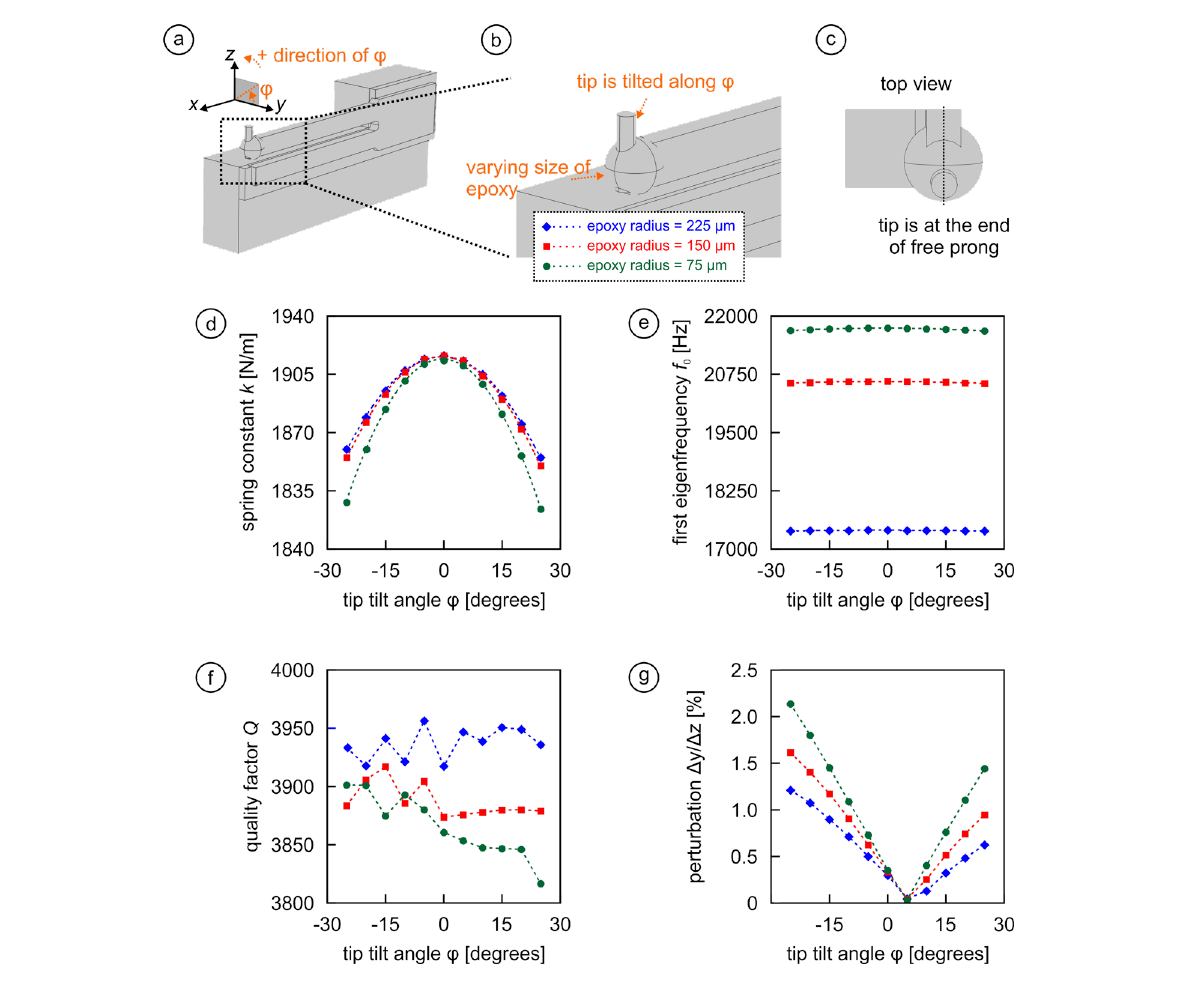
Figure 2: Effect of the tip tilt angle φ on k , f 0 , Q , and Δ y / Δ z for three different epoxy amounts used to attach the tip to the end of the free prong of the fork (green: 75 µm; red: 150 µm; blue: 225 µm). (a–c) Illustration of the geometrical arrangement and definition of the angle φ . (d) Increasing tip tilt results in decreasing spring constants regardless of the epoxy amount used. (e) The additional mass that goes along with larger amounts of glue reduces the eigenfrequency of the sensor significantly, but almost no effect of the tip tilt is detected. (f) Q changes by less than 0.1% within the screened parameter space. (g) Due to the assembly asymmetry introduced by tip tilting, the perturbation grows to over 2% for large tilt